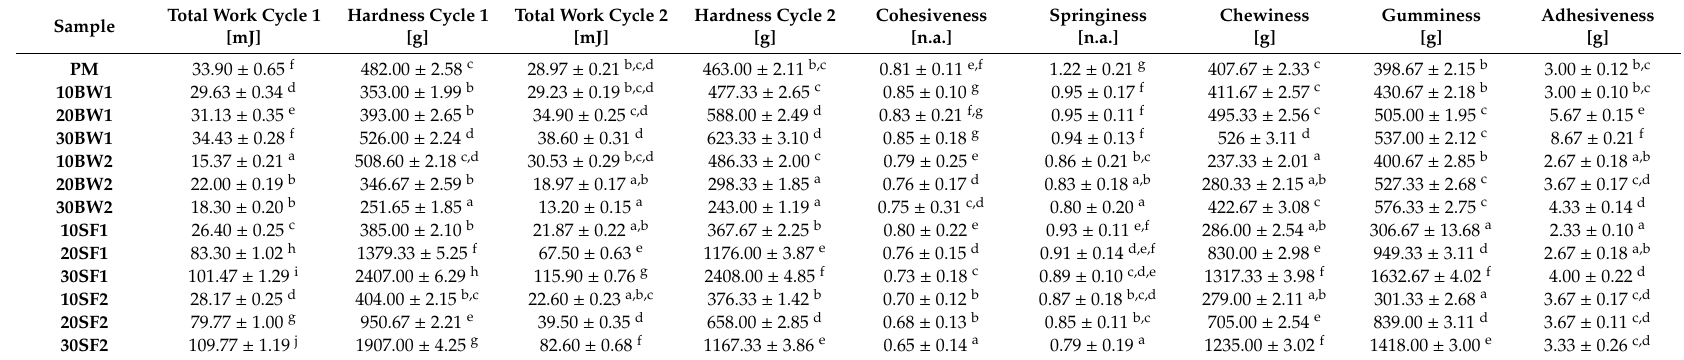
Table 9. Textural analysis of baked